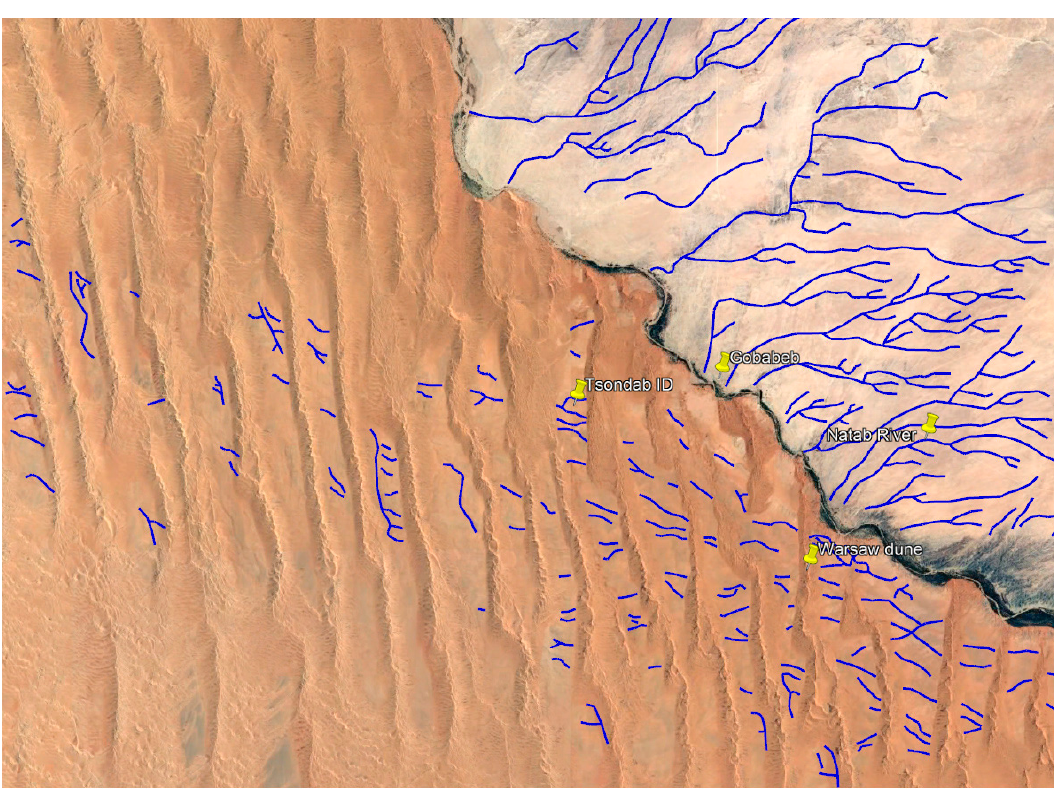
Figure 3. ( Top ): Landsat image of the Kuiseb River area with radar-detected channels indicated in blue. ( Bottom ): Corresponding PALSAR-2 radar image.